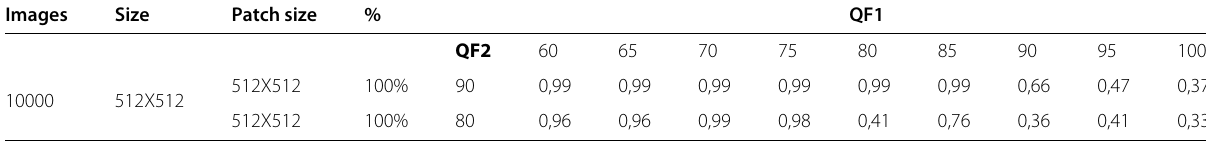
Table 5 Accuracy obtained by the proposed approach on BOSSBase [31] dataset with different patch size and QF 1 / QF 2 Images